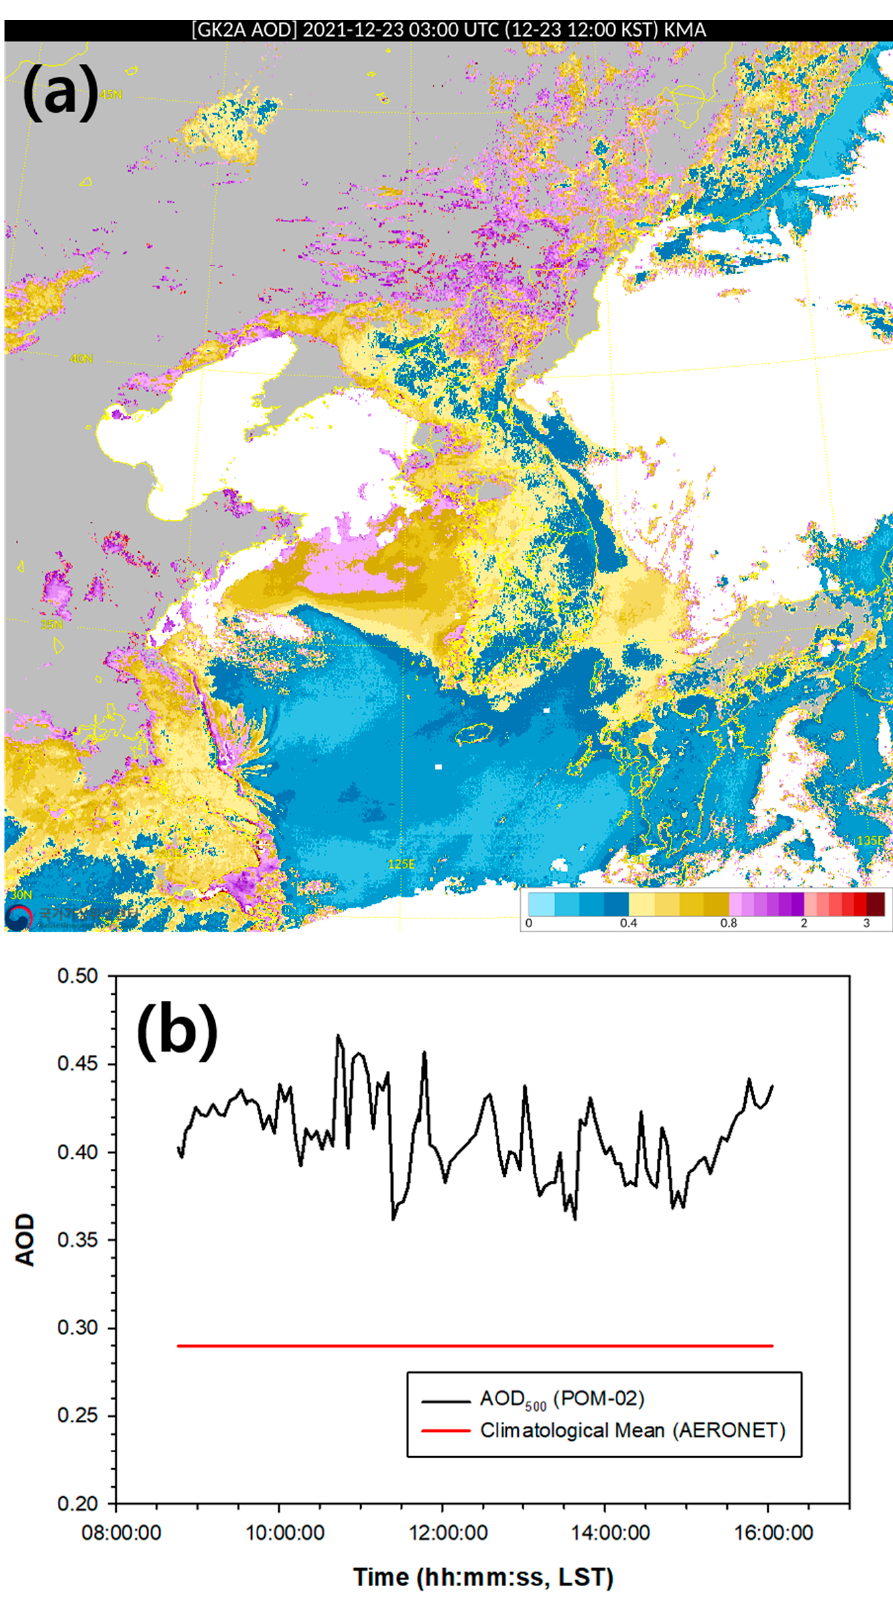
Figure 8. ( a ) Horizontal distribution of aerosol optical depth from GK–2A imagery. ( b ) Time series of instantaneous aerosol optical depth from the POM-02 skyradiometer (black solid) at the Korea Institute of Energy Research (KIER) station and monthly mean aerosol optical depth from the Aerosol Robotic Network (AERONET) station at 1200 Local Standard Time (LST) on 23 December 2021. Table 2 summarizes the error statistics for all the runs. The control run results in MAE values that are averaged over all clear days as 29.9 W m − 2 with a standard deviation of 10.2 W m − 2 . Simulations using the in situ observations, S1 and S2, reduced the MBE to 1.5 and − 5.6 W m − 2 , respectively. Corresponding to the improvement in the bias error, the